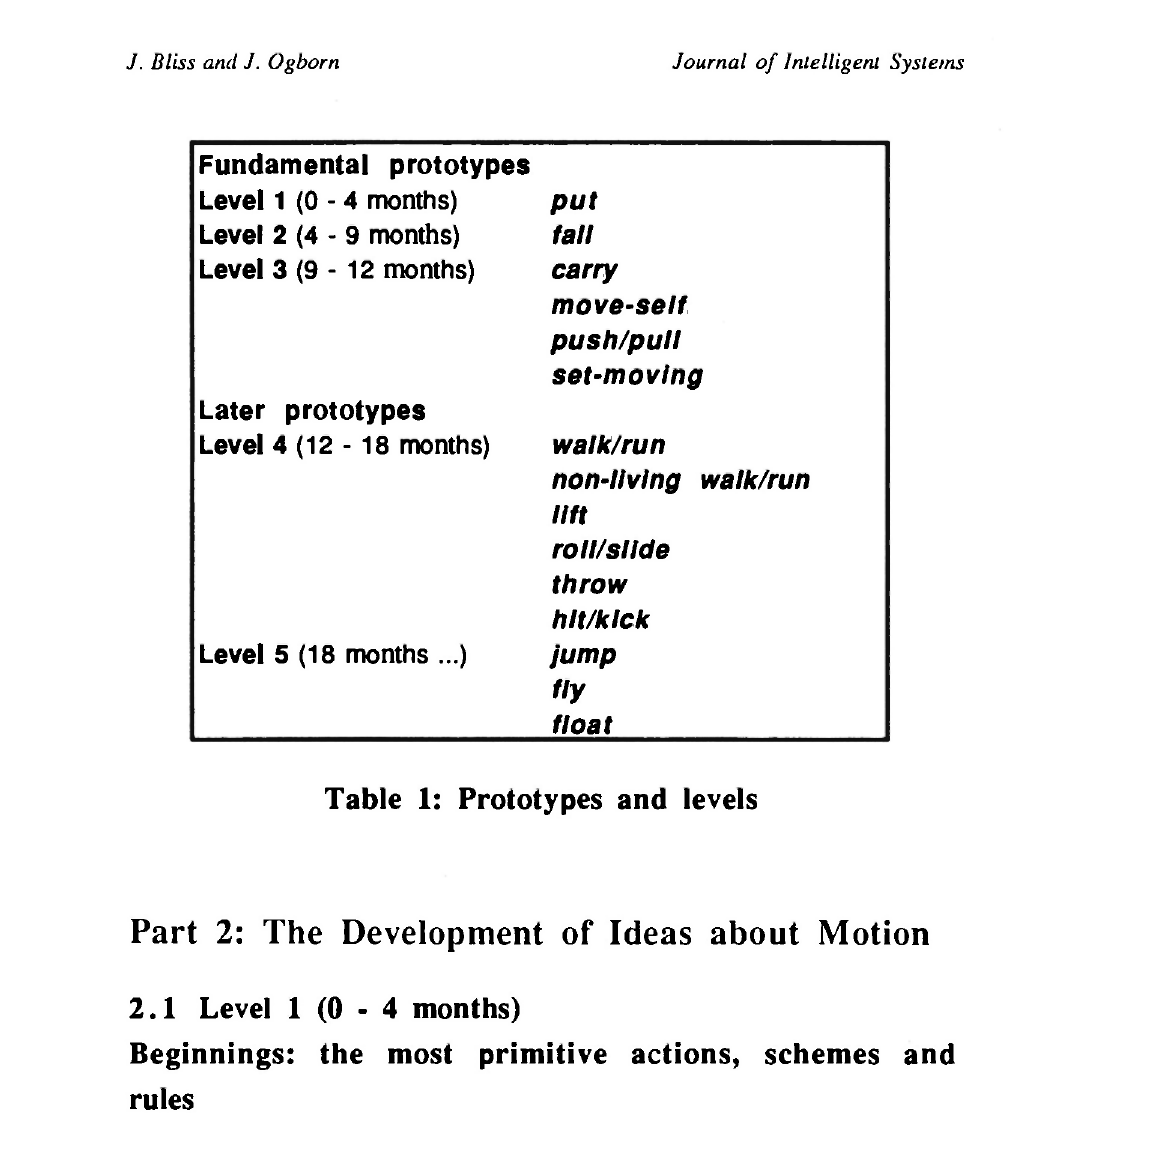
Table 1: Prototypes and